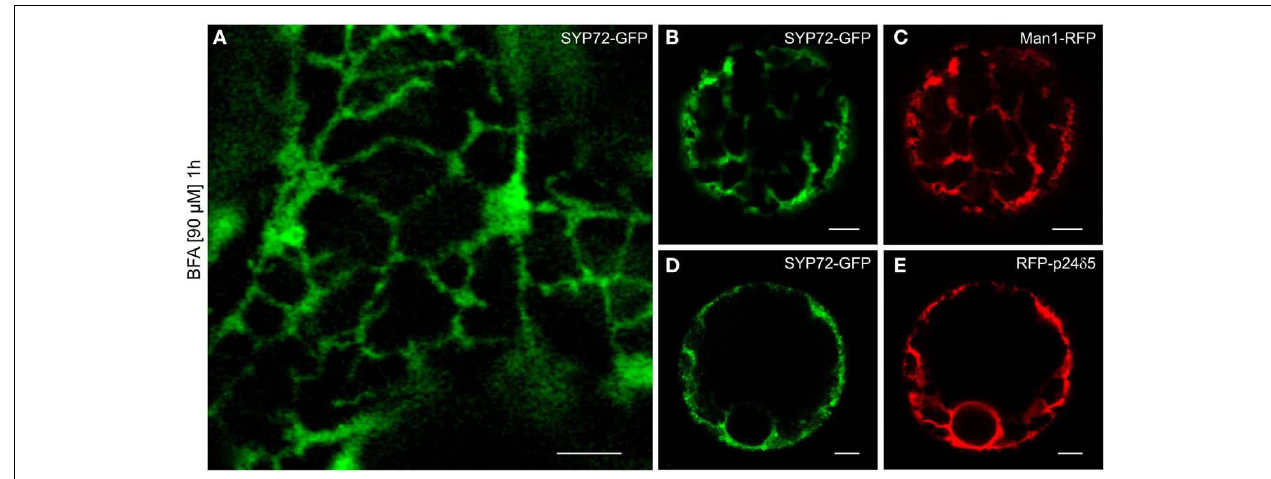
FIGURE 9 | BFA prevents formation of SYP72 punctae. Pretreatment with BFA (90 µ M; 1h) leads to a general ER distribution of SYP72-GFP signals in leaf epidermal cells (A) , and protoplasts (B–E) when coexpressed with the Golgi marker Man1-RFP (C) or the ER marker RFP-p24 δ 5 (E) . Magnification bars (A–E) = 5 µ